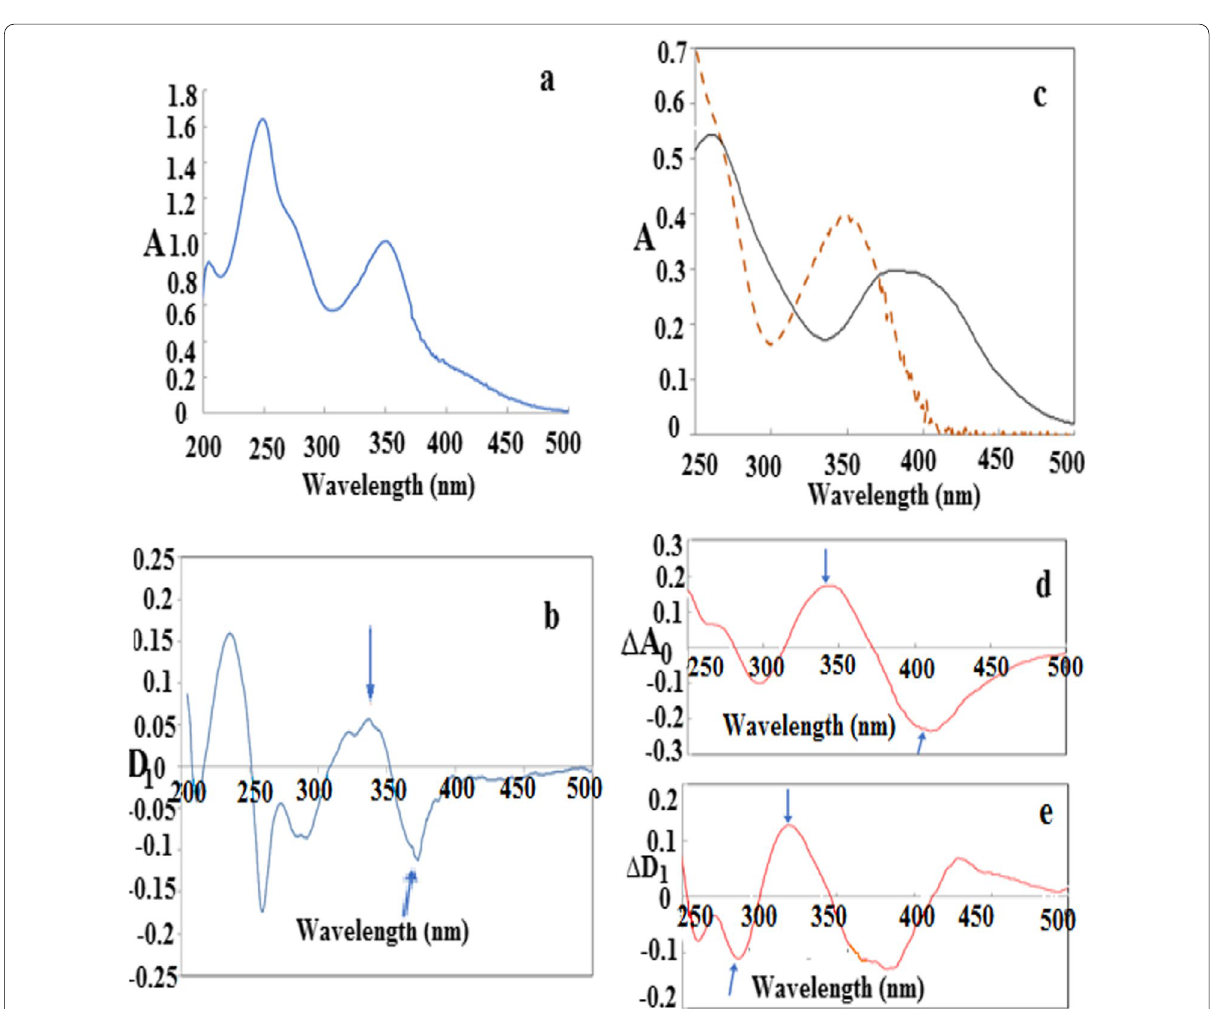
Fig. 4 Absorption ( a ) and its first derivative ( b ) spectra of 100 µg/ mL TIG in methanol, ( c ) Absorption spectra of 40 µg/mL TIG in 0.1 M HCl (‑‑‑) and in 0.1 M NaOH (__), ( d ) the difference absorbance spectrum and ( e ) its corresponding first derivative spectra in 0.1 M HCl against its solution in 0.1 M